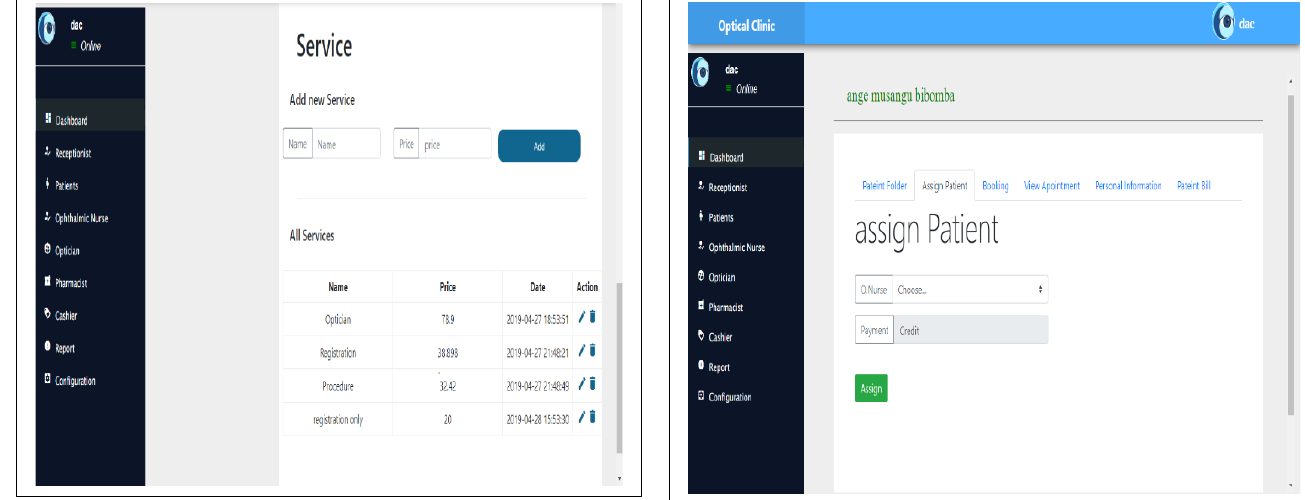
Figure 20. Add New Service Interface